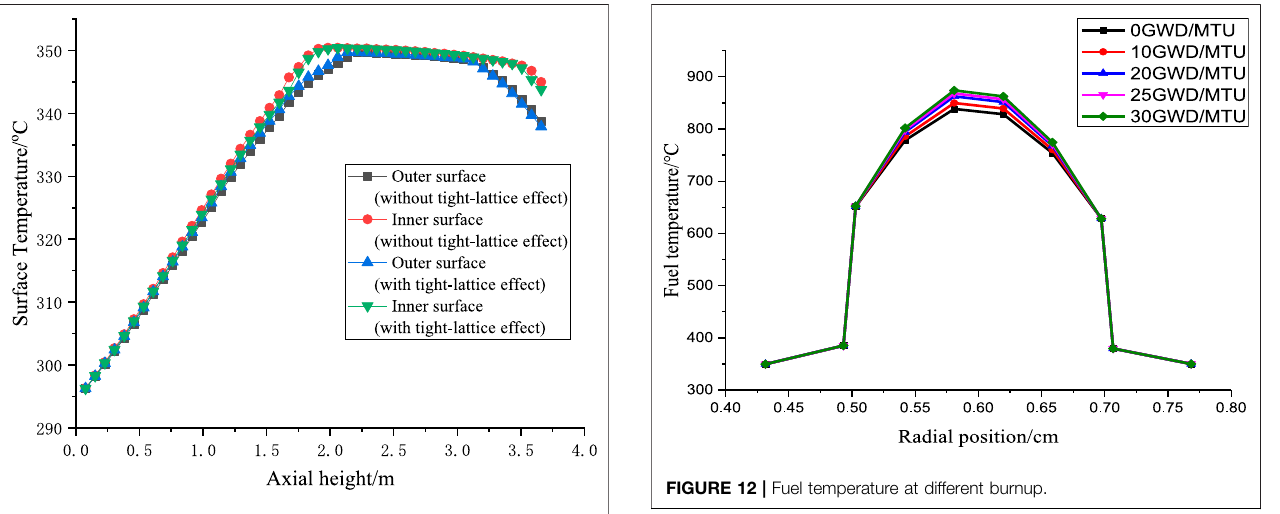
FIGURE 11 | Inner and outer surface temperature distribution of rod 13 before and after considering the tight lattice effect.